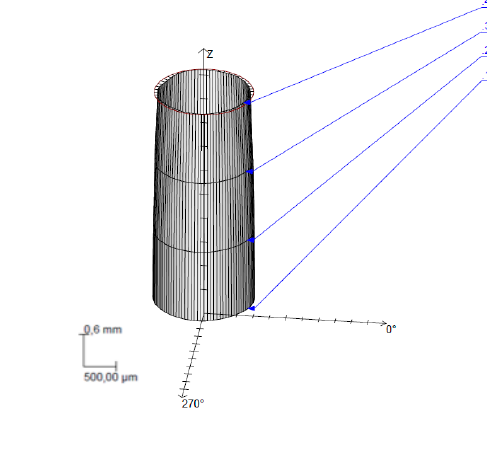
Figure 17. Straightness deviations results on: ( a ) UNS A97075/CFRP configuration; ( b ) CFRP/UNS A97075 configuration.